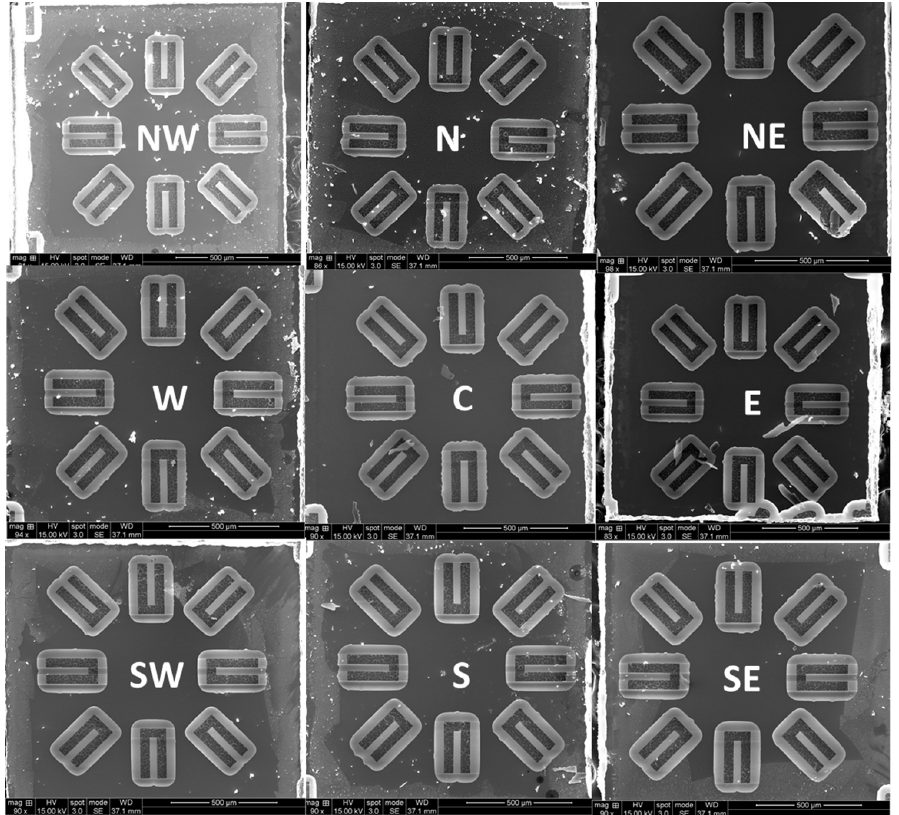
Figure 7. Top view SEM images of cantilevers formed from a 5-layer, 500 nm total thickness, PVD deposited Al 0.68 Sc 0.32 N where the process gas flow for each layer is linearly changed from 30 to 20 sccm through the five layers. Each die was pull from the north (N), northeast (NE), east (E), south- east (SE), south (S), southwest (SW), west (W), and northwest (NW) locations of the wafer shown in Figure